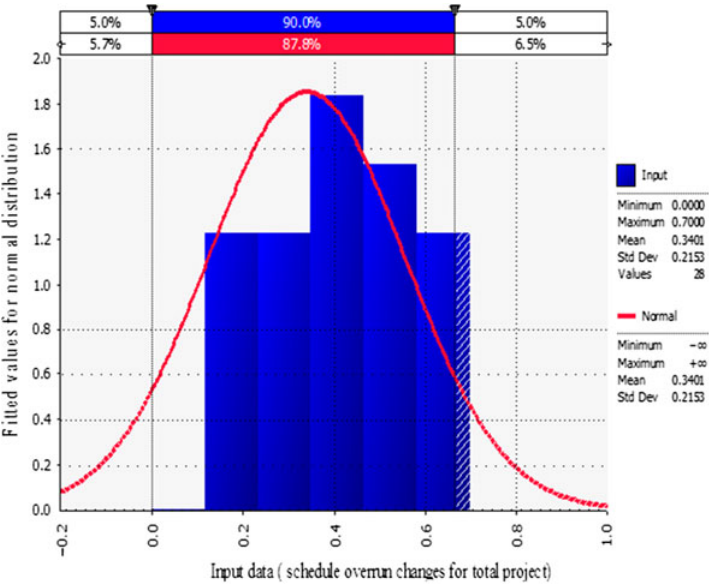
Fig. 1. Histogram of schedule growth at the completion of the